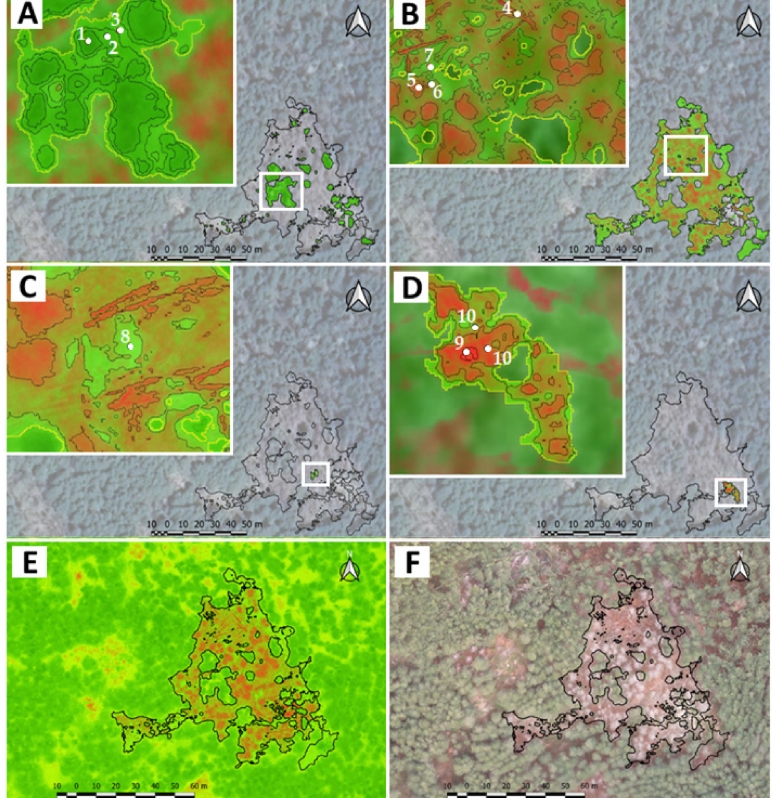
Figure 4. Vegetation categories in a bark beetle spot in Kirkovo region: ( A ) living trees, (1) central part of the crown projection; (2) peripheral part of the crown projection; (3) spaces between tree crowns); ( B ) dead trees, (4) lying trees; (5) central part of the crown projection of standing trees; (6) peripheral part of the crown projection of standing trees; (7) spaces between crowns of standing trees); ( C ) grass and shrub vegetation (8); ( D ) stones and rocks, (9) without mosses; (10) with mosses; ( E ) NDVI image of studied spot; ( F ) RGB image of studied